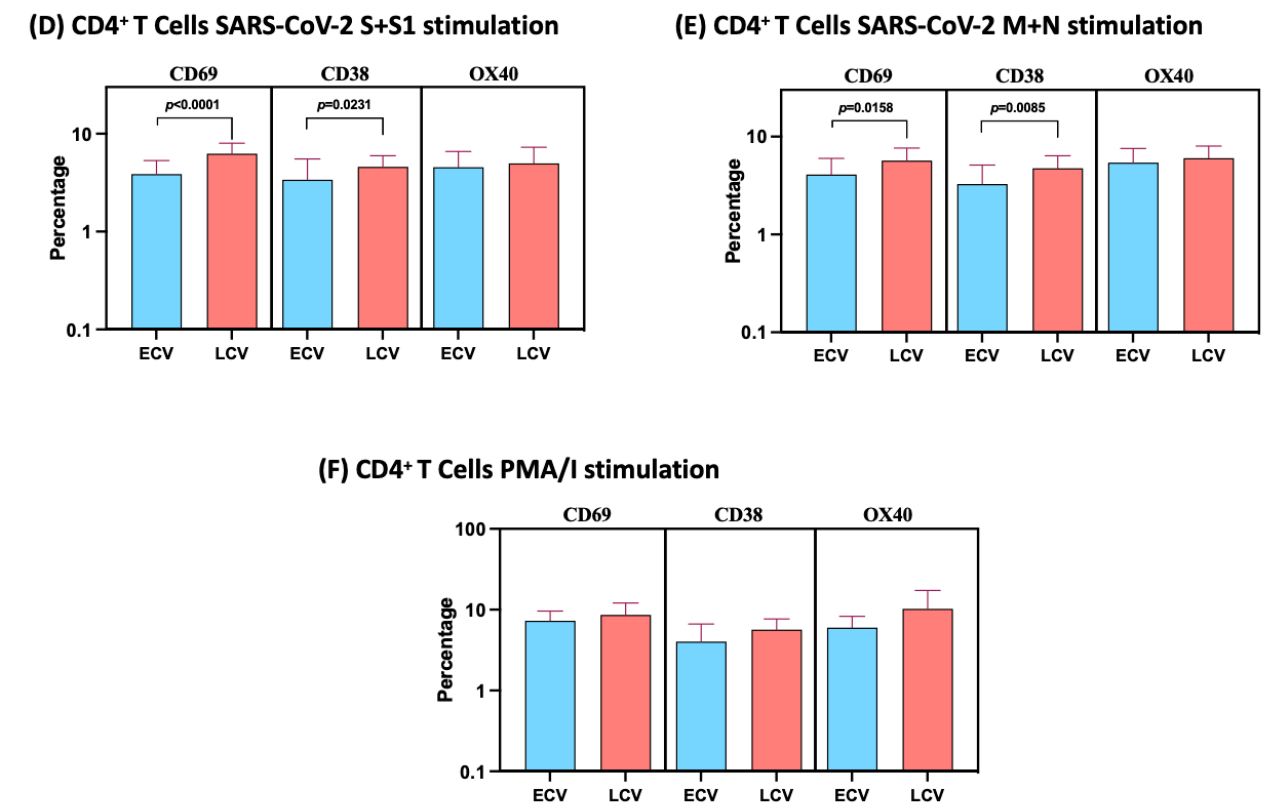
Figure 1. Enhanced frequencies of CD4 + T cells expressing activation markers in late convalescent COVID-19 individuals. PBMCs were cultured with media alone or SARS-CoV-2 or control anti- gens for 12 h and the baseline and antigen-stimulated frequencies of CD69, CD38 and OX-40 were determined in early convalescent (ECV) COVID-19 ( n = 20) and late convalescent (LCV) COVID-19 in- dividuals ( n = 20). ( A ) Gating strategy and representative plots for CD4 + T cells expressing activation markers. ( B ) The frequencies of CD4 + T cells expressing activation markers in early and late conva- lescent individuals at baseline ( B ) as well as in response to stimulation with ( C ) SARS-CoV-2 WCL, ( D ) SARS-CoV-2 S+S1 peptide pools, ( E ) SARS-CoV-2 M+N peptide pools and ( F ) PMA/Ionomycin were measured by flow cytometry. The bars represent the geometric mean values. p values were calculated using the Mann–Whitney test. Any comparison that is not labelled with a p value is statistically